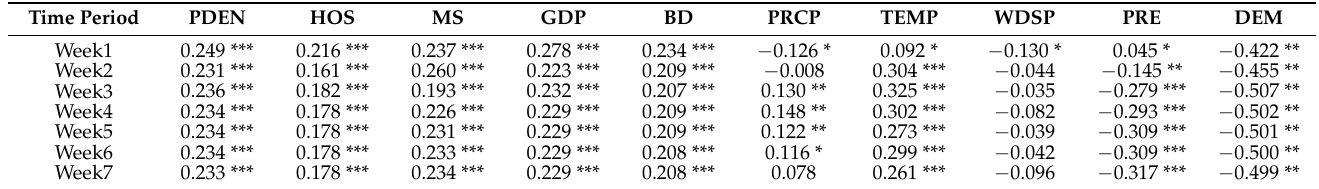
Table 8. Pearson correlation coefficients between IFR and risk factors in Mainland China.